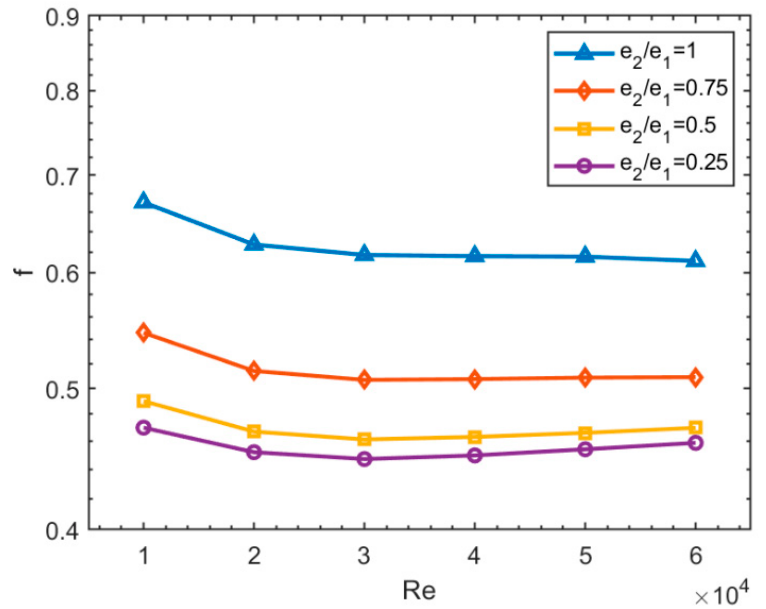
Figure 9. Friction (f) value variation with the Reynolds number at different rib height ratios. Figure 9. Friction factor (f) variation with the Reynolds number at different rib height